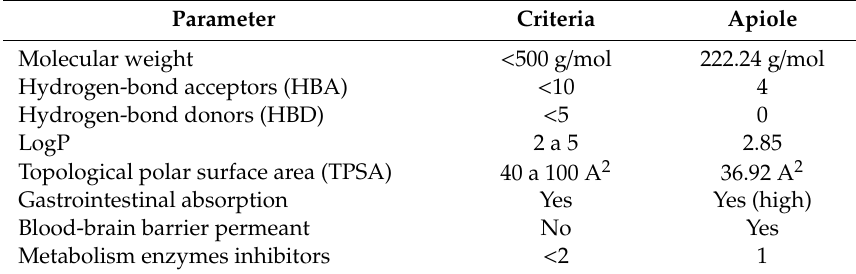
Table 6. Pharmacokinetics parameters predicted for apiole in comparison to Lipinski’s